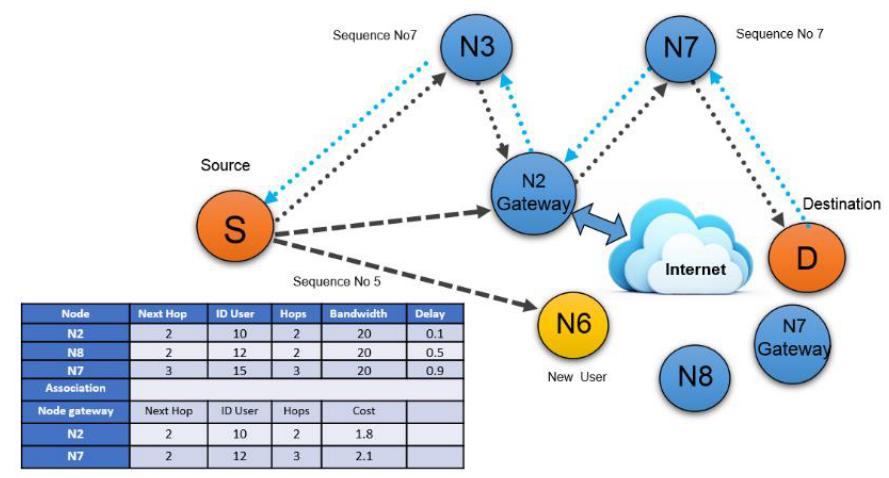
Figure 5. New user connection request using AODV.